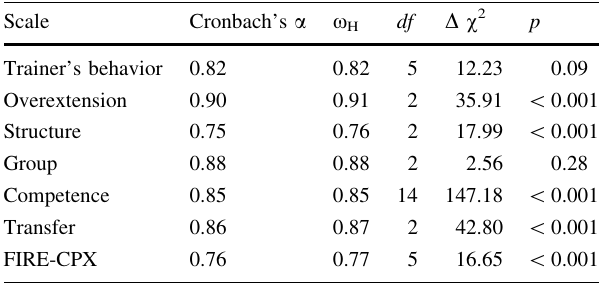
Table 2 Reliability coefficients and measurement model tests for all FIRE-CU scales and FIRE-CPX Scale